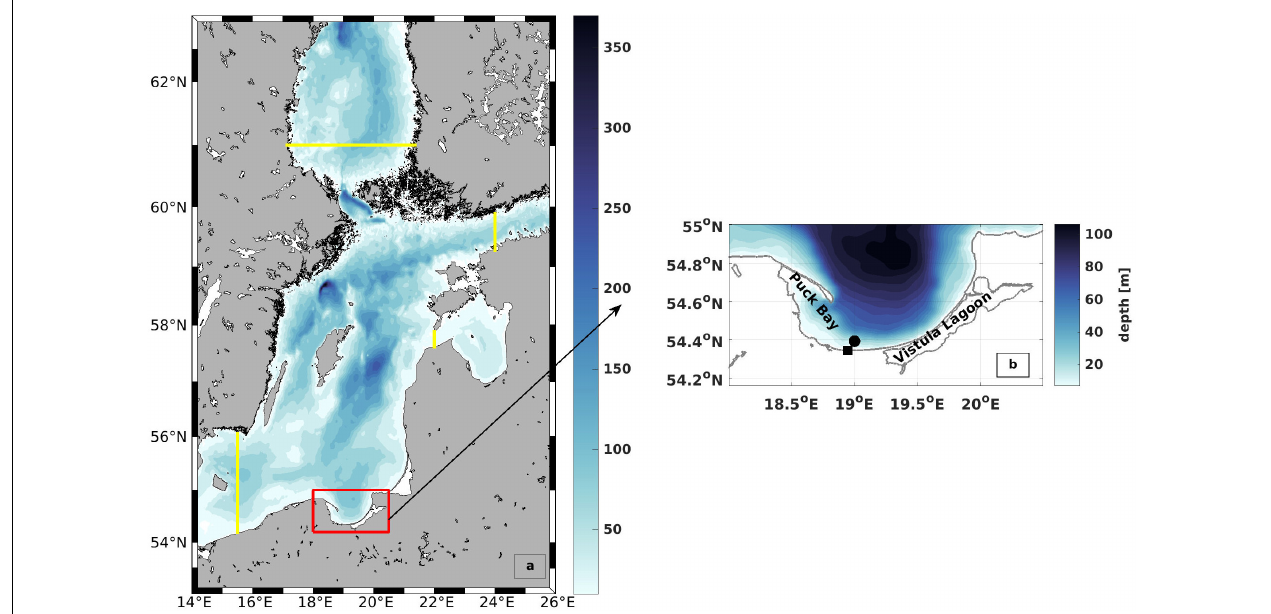
FIGURE 4 | Model domain and bathymetry (a) The outer model along with the inner high resolution model that was used for this research. The yellow lines mark the location of the open boundaries. The red box shows the location of the study area (b) Bathymetry of the Bay of Gda´nsk. The black square indicates the entrance of the Vistula River (VR) and the black dot indicates the area of the model